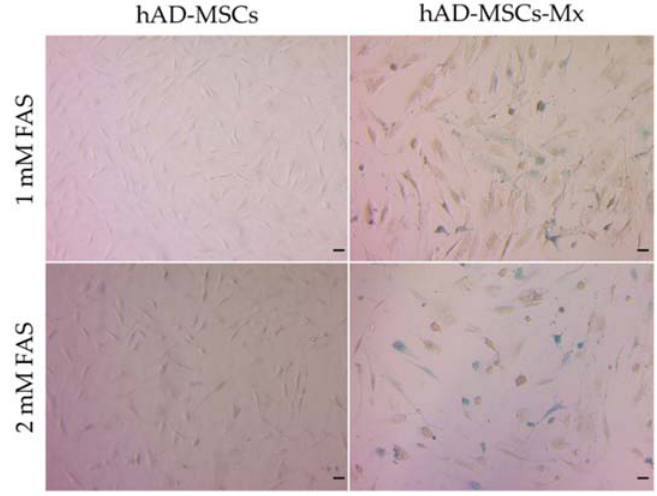
Figure 4. Prussian blue staining of hAD-MSCs and hAD-MSCs-Mx after 24 h incubation with 1 mM or 2 mM FAS. White-field microscopy, Zeiss Primo Vert, scale bar 50 µm.